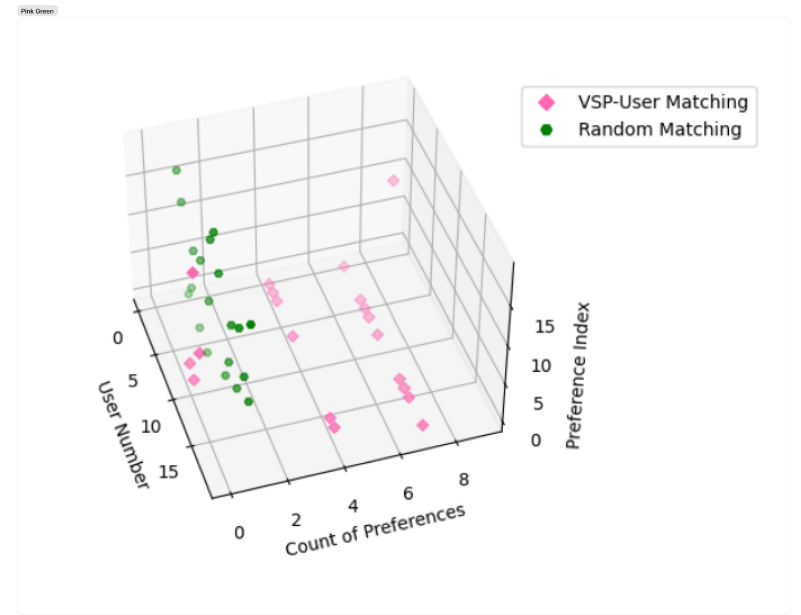
Figure 9. A three-dimensional plot between users and the preference index of allocated VSP while also factoring in and showing the frequency with which a particular preference index is